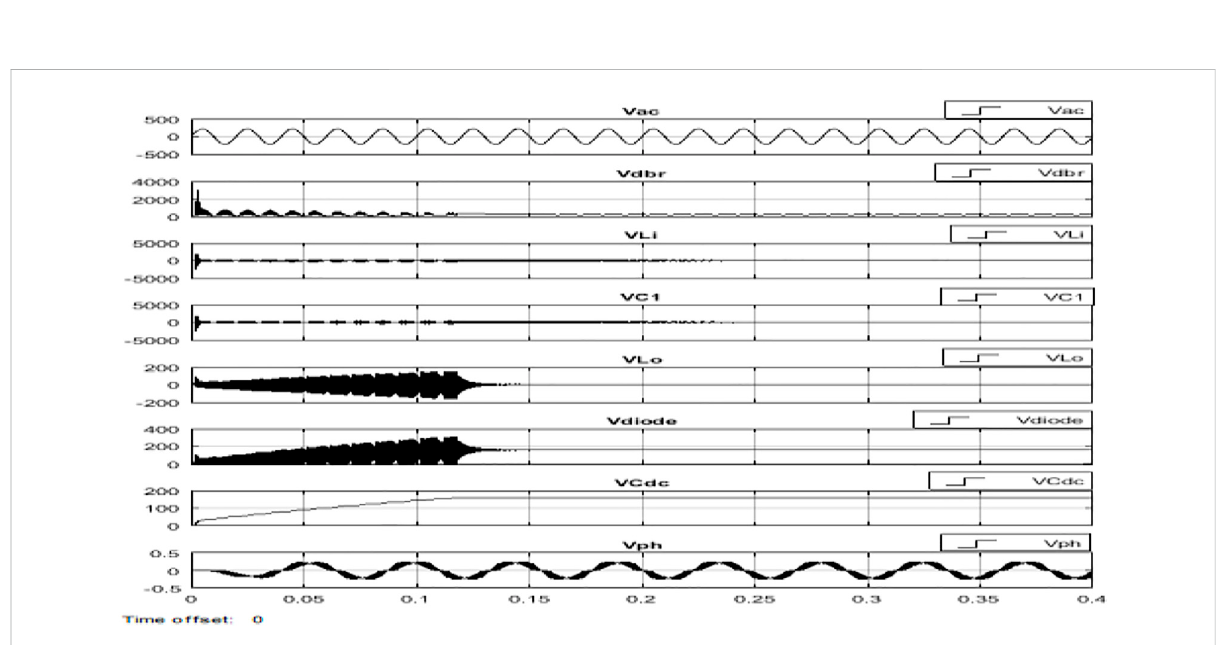
FIGURE 14 Voltage waveforms of BLDC motor